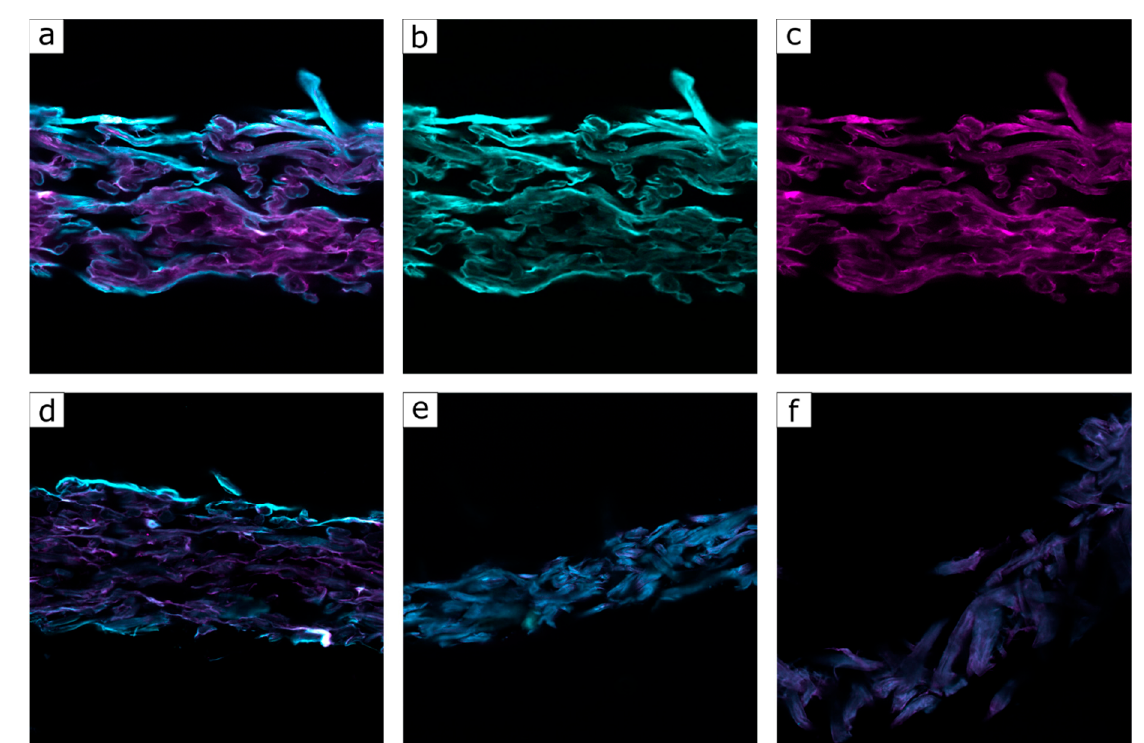
Figure 11. Confocal laser scanning microscopy (CLSM) images of cellulose fibers. ( a – c ) coated with P(FA-co-StMA-co-HEMA-co-RhBMA); ( a ) calcofluor channel and RhBMA channel, shows the fiber and polymer, ( b ) calcofluor channel shows the fibers, ( c ) RhBMA channel shows the polymer. ( d – f ) Coated with P(FA-co-StMA-co-HEMA-co-RhBMA), ( d ) untreated fiber with the calcofluor channel and the RhBMA channel, ( e ) non-cross-linked coating, but extracted fiber, ( f ) cross-linked and extracted fiber.